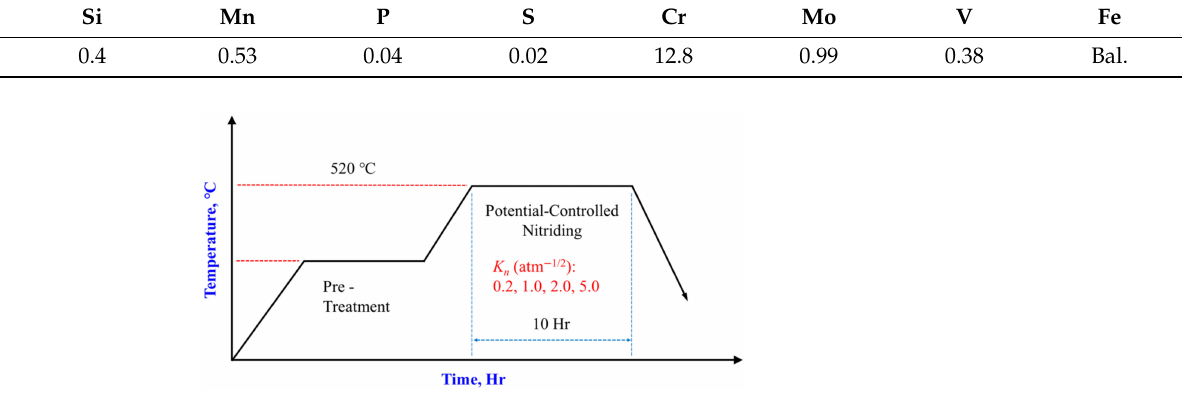
Figure 1. Nitriding of AISI D2 specimens as a function of nitriding